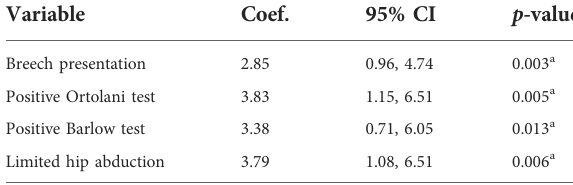
TABLE 7 Internal validity. Variable